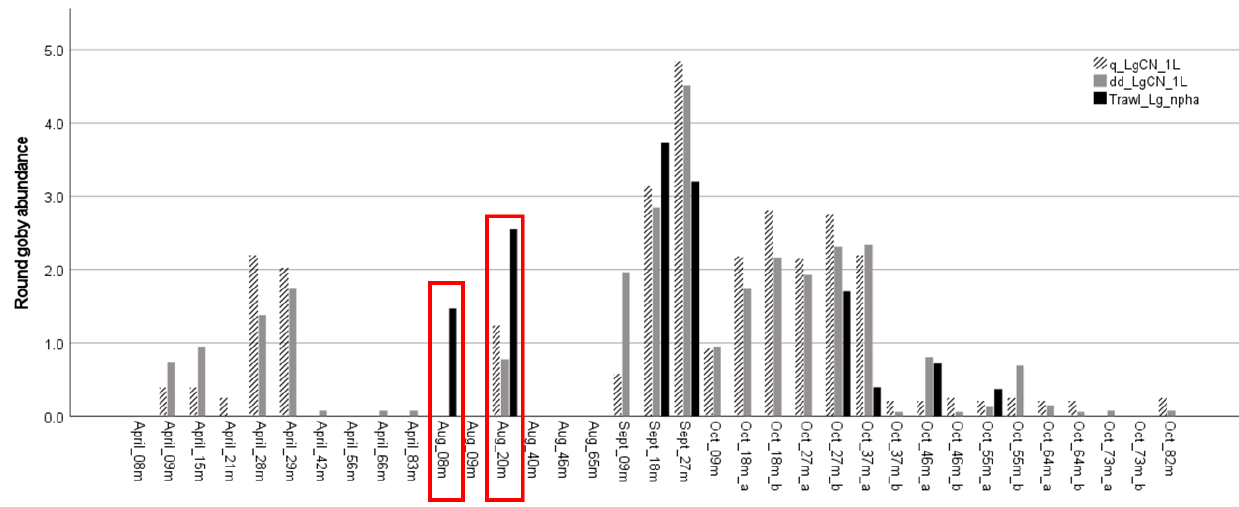
Figure 4. Round goby ( Neogobius melanostomus ) abundance estimates by trawl (number of fish per hectare), quantitative PCR (qPCR) and droplet digital PCR (ddPCR) (mean copy numbers per liter (CN/L)). Values are log 10 transformed. Bars for “Sept” represent sampling in Lake Michigan and all other bars represent samples in Lake Huron. On the x-axis, there are months: Aug = August, Sept = September, Oct = October; depths: 8–83 m, “a” and “b” represent different sites at the same depth. Two records, outlined in red, represent instances where eDNA water samples were collected four days after trawls.